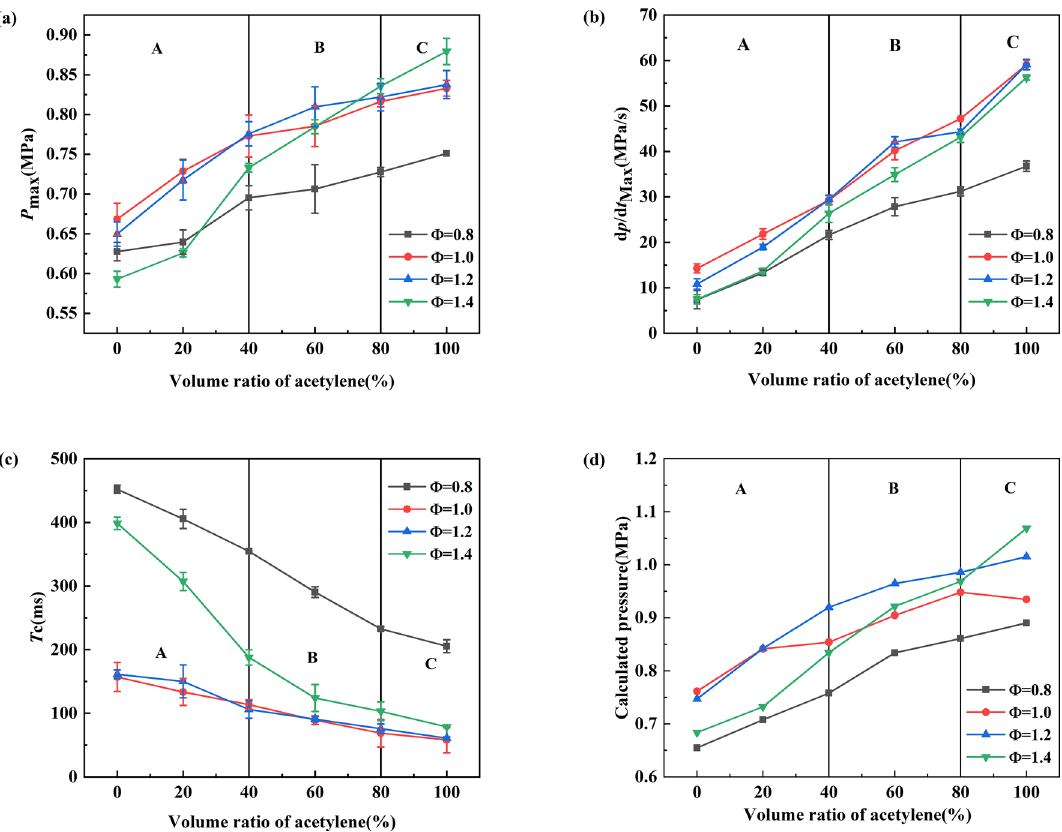
Figure 6. Explosion parameters for a methane–acetylene–air mixture [( a ) P max , ( b ) (d P /d t ) max , ( c ) T c , and ( d ) calculated